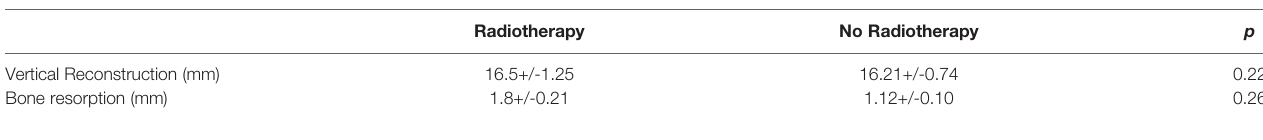
TABLE 3 | Effects of radiotherapy in vertical reconstruction and bone resorption.